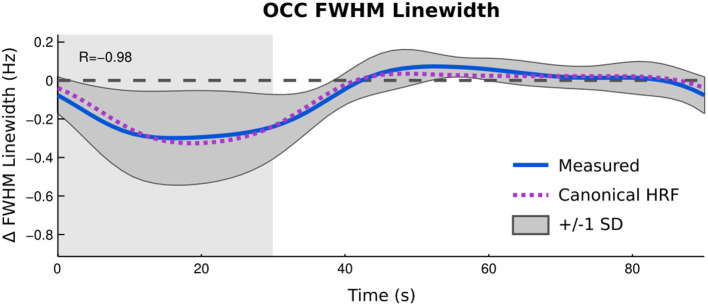
Time resolved analysis of changes in FWHM of unsuppressed water signal compared to predicted BOLD response between active blocks (gray background) and rest (white background). Zero line indicates average linewidth during rest blocks.